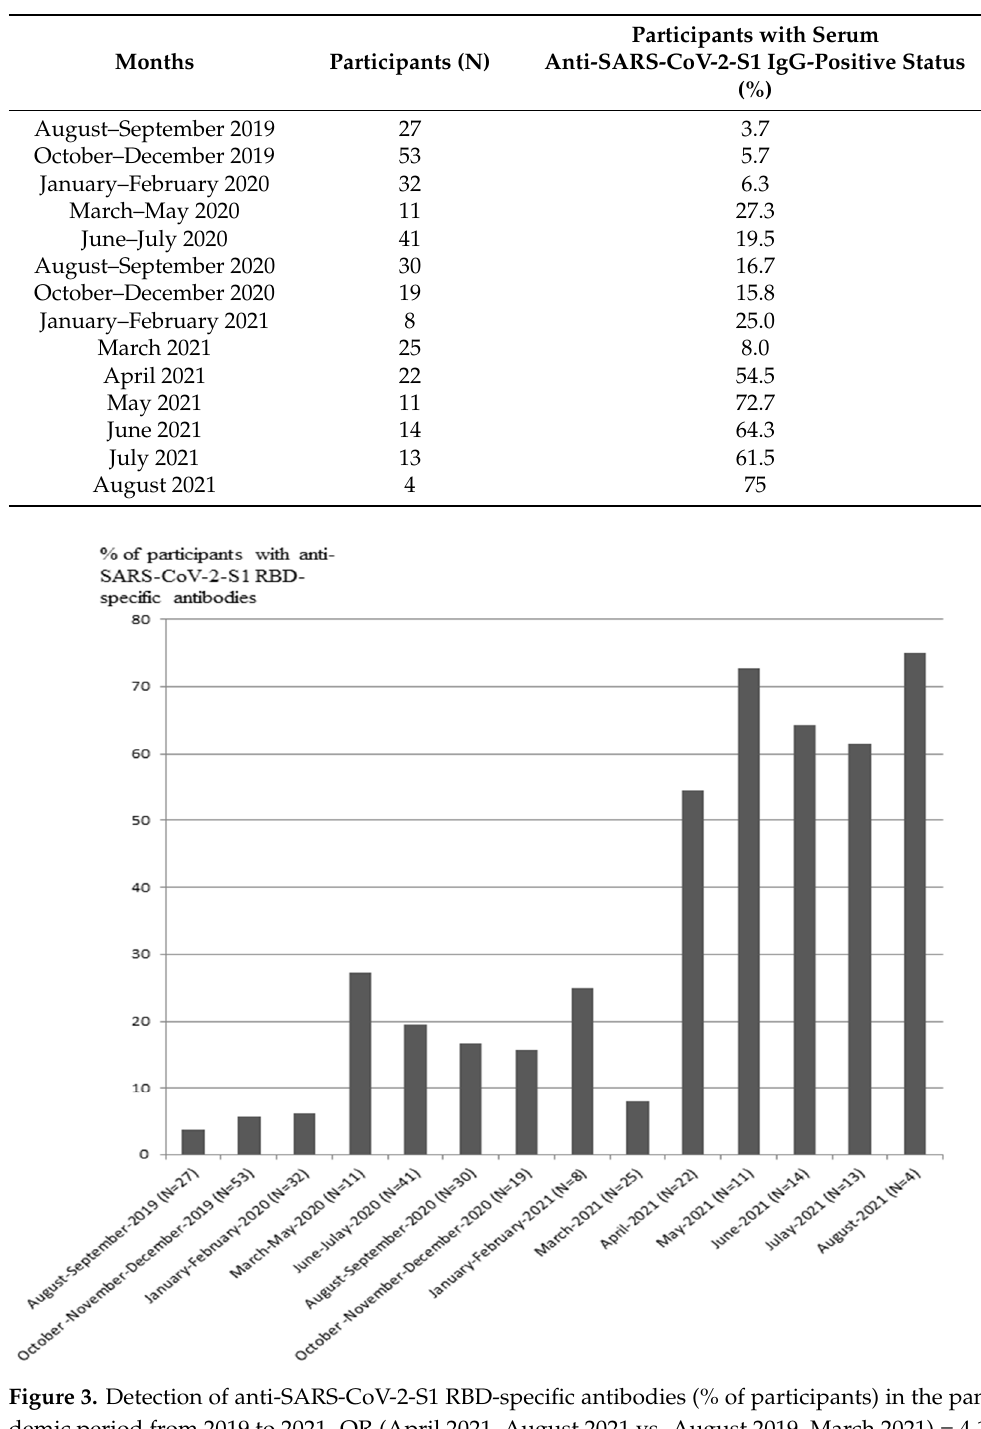
Table 2. Participants (N and %) with serum anti-SARS-CoV-2 (S1) IgG-positive status based on indi-